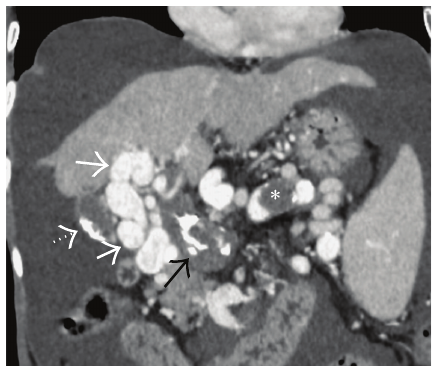
Figure 47: Coronal oblique CECT image showing chronic, partially calcified, occlusive thrombus involving the main portal vein (black arrow) with multiple tortuous periportal collateral channels (solid white arrows). Splenic vein is also partially thrombosed (asterisk). Gall bladder calculi (interrupted arrow) and ascites can also be seen.